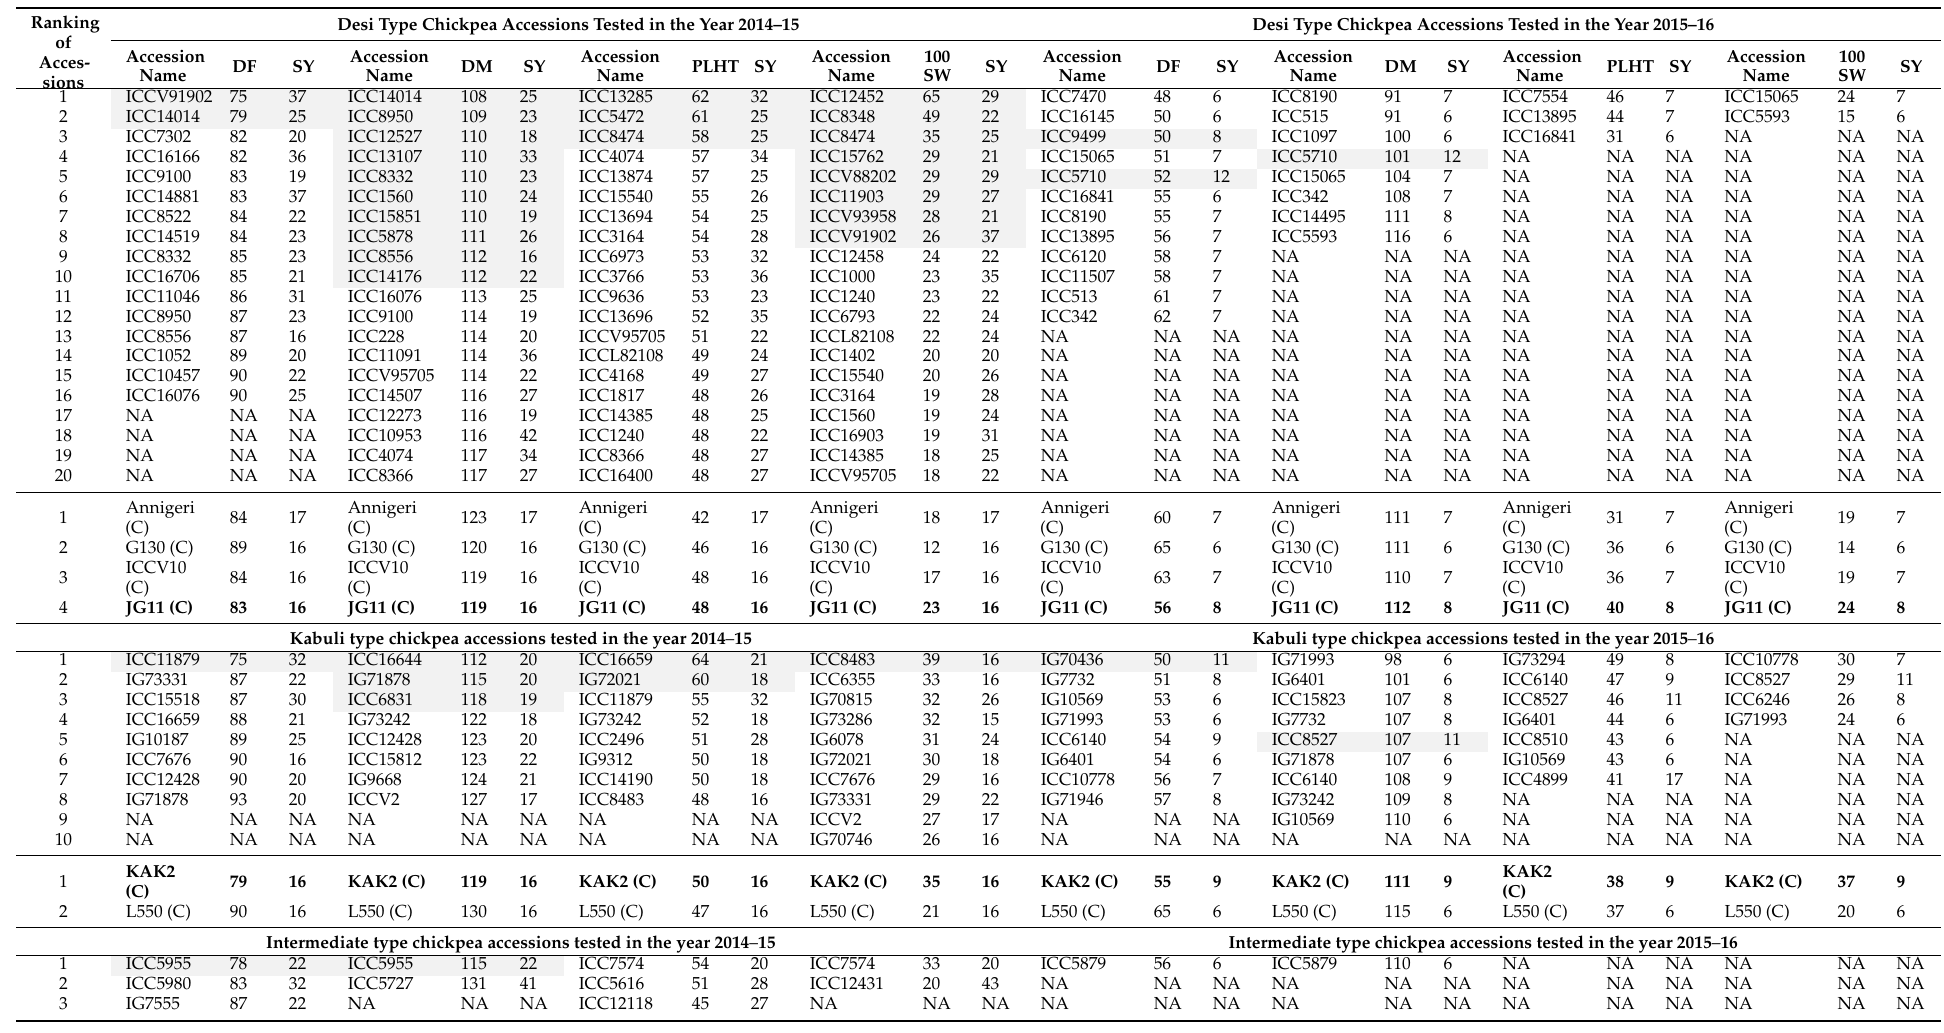
Table 3. Shortlisted germplasm accessions based on ranking biplot for five traits across two years for Amlaha, Madhya